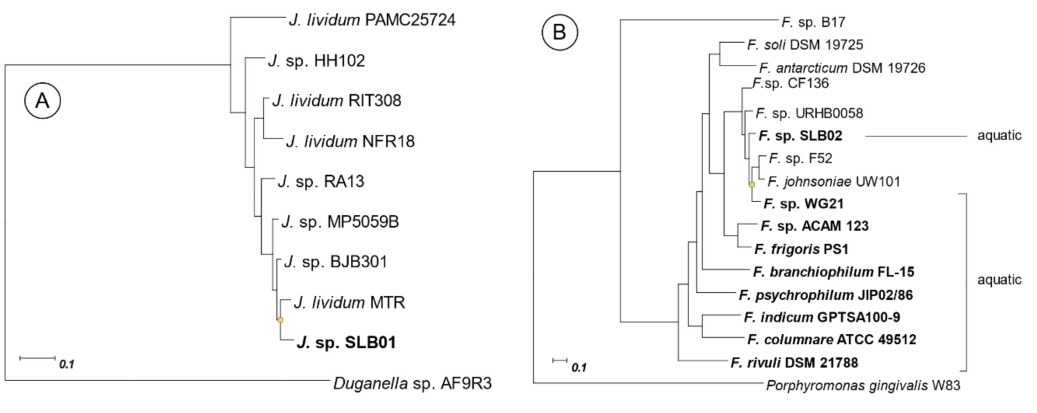
Figure 1. Phylogenetic tree of Janthinobacterium sp. SLB01 ( a ) and Flavobacterium sp. SLB02 ( b ) with closely related species. Trees are built based on approximately 400 universal marker genes by PhyloPhlAn (a maximum-likelihood method). GenBank accession numbers are given in Tables S1a and S1b. Strains of Flavobacterium with an aquatic niche are highlighted with a bold